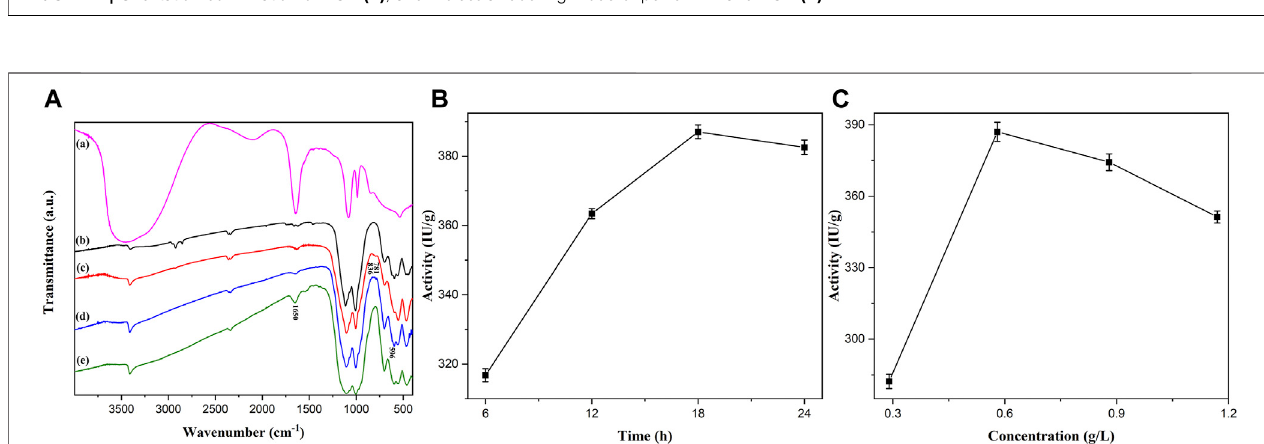
FIGURE5 | The Fouriertransforminfrared(FTIR) spectra (A) ofthe PGAimmobilization process and the in fl uences oftime (B) and concentration (C) on the activity of PGA.